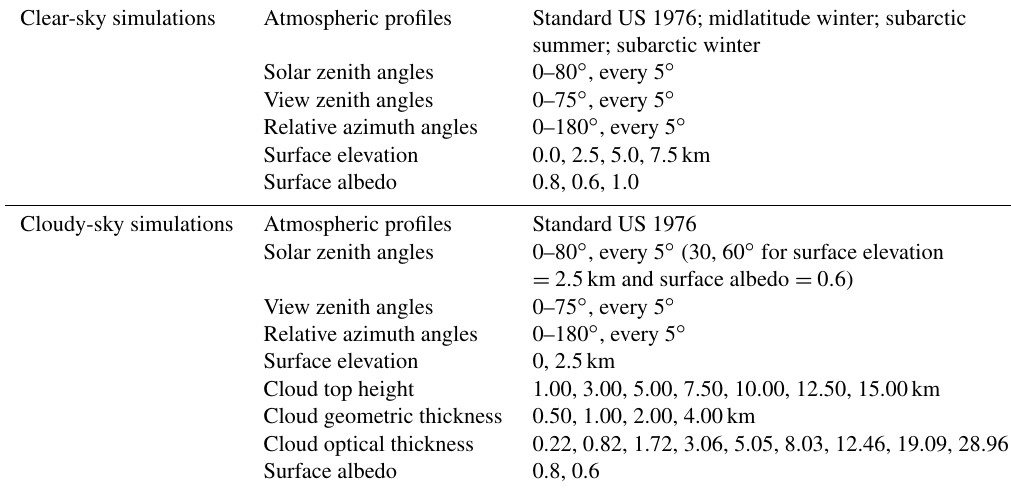
Table 1. Parameter setup in radiative transfer model simulations.